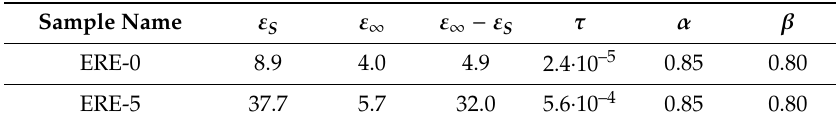
Table 1. The results of fitting the dielectric spectra of composite elastomer samples to Havriliak– Negami